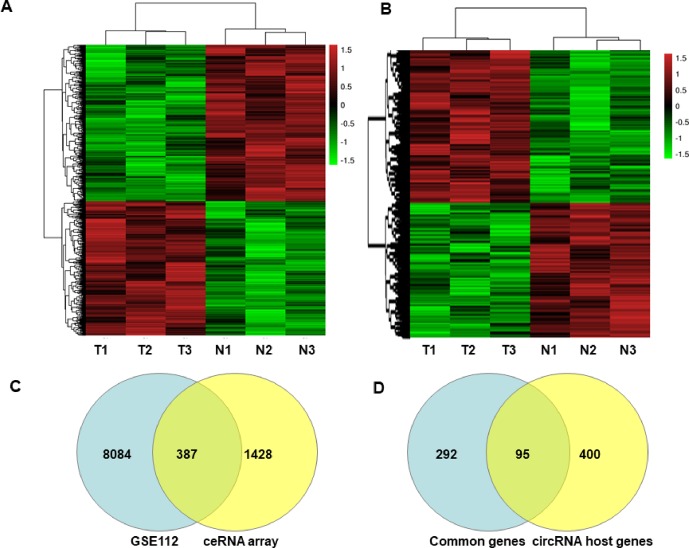
Heatmaps and Venn Diagrams showing the differential mRNAs, circRNAs and their host genes in GISTs. Heat maps of the differentially expressed mRNAs (A) and circRNAs (B). Venn Diagrams showing that the common 387 mRNAs (C) were from differential mRNAs in the GEO dataset (GSE112) and our ceRNA array, and 95 common mRNAs were from overlapped 387 genes and differently expressed circRNA host genes in our ceRNA array (D).